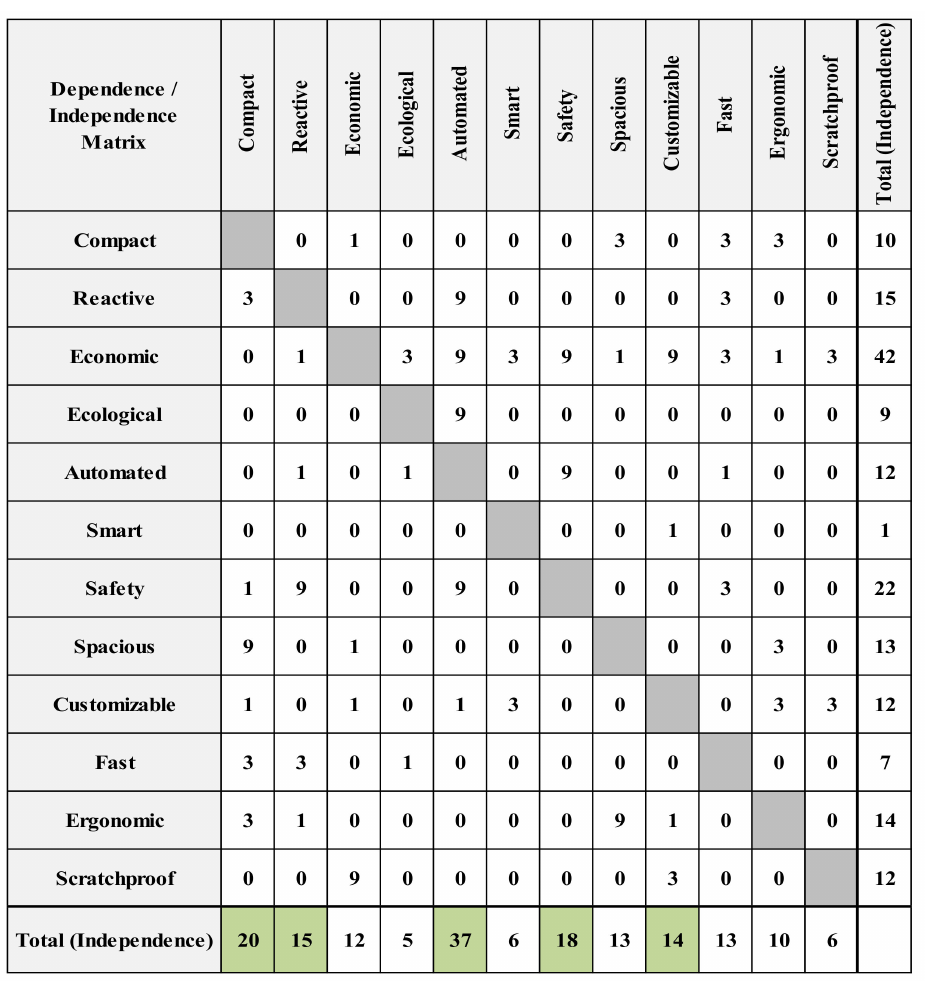
Figure 7. Dependence / Independence